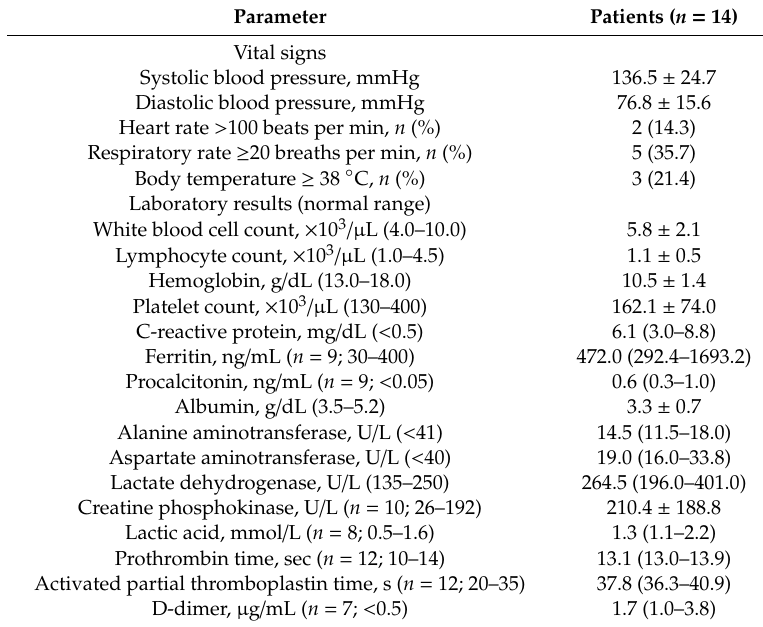
Table 2. Vital signs, laboratory data, and imaging findings on